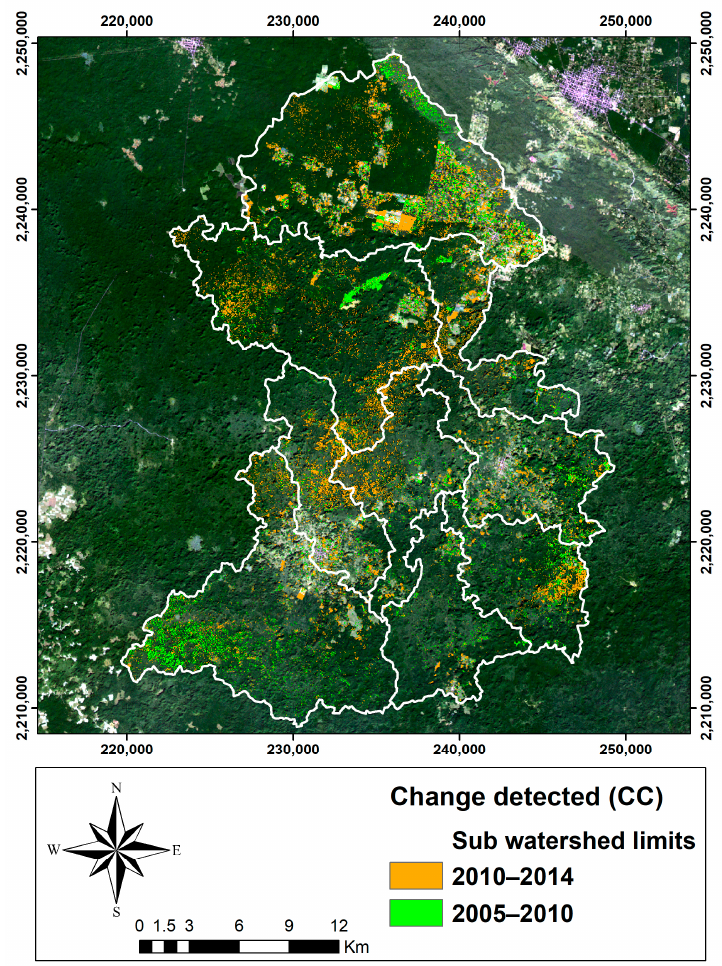
Figure 4. Areas identified as breakpoints for detection of forest degradation using Bfast.